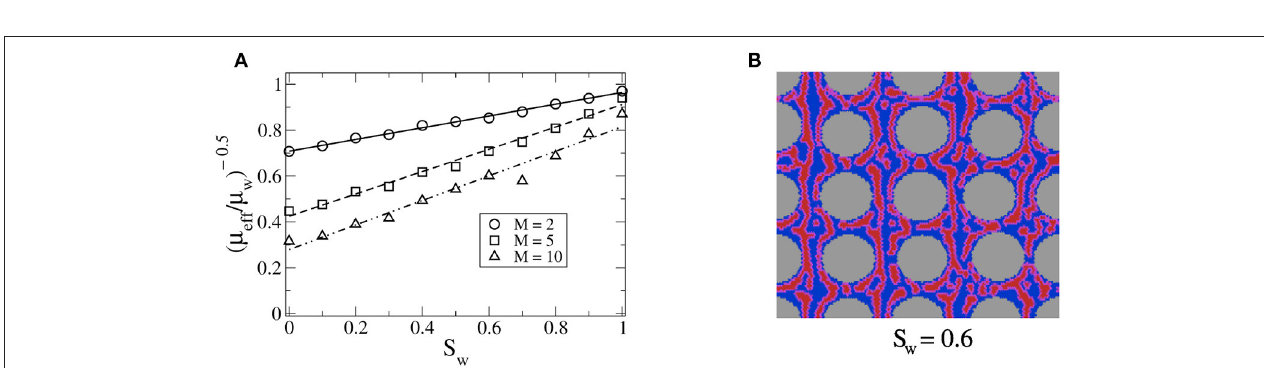
0.5. The steady state is dominated by = − 1 fall a little below 1, which could have several explanations, one being finite =